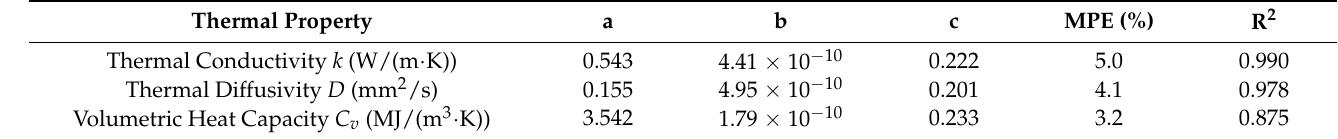
Table 2. Regression coefficients, R 2 and mean percentage error (MPE) of the model for liver tissue. Thermal Property a Thermal Conductivity k (W/(m · K))